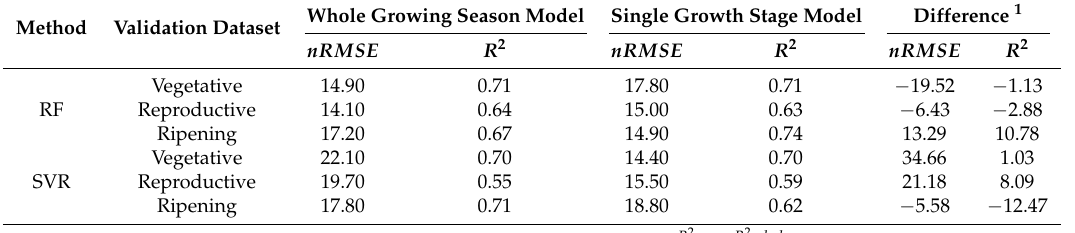
Figure 6. Calibration (with CV) and validation nRMSE of different multivariate calibration methods. The whole growing season and single growth stage models built on original and first-derivative spectra are shown in different panels Table 6. The validation nRMSE and R 2 of random forests (RF) and support vector regression (SVR) models on first-derivative spectra for the whole growing season and each single growth stage. The whole growing season models were validated on each separate growth stage data of the 2017 growing